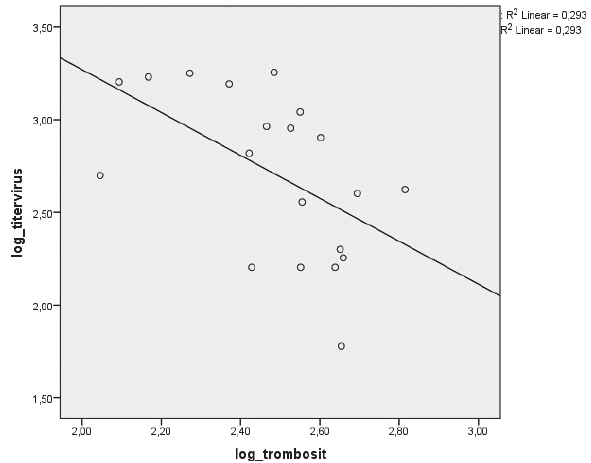
Figure 5. Correlation between the Virus Titer Log and the Platelet